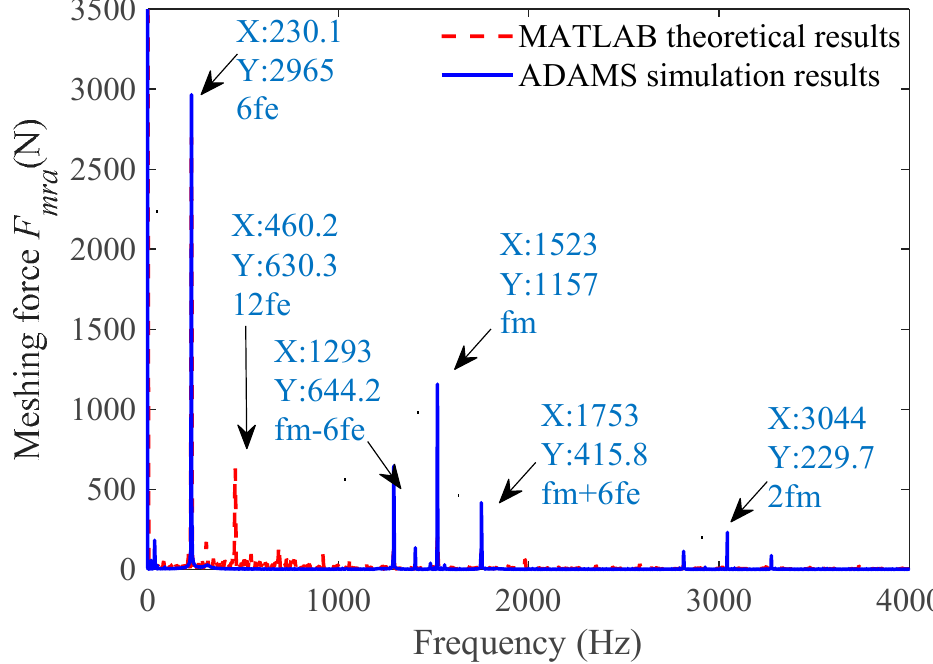
. (cid:3040)(cid:3028)(cid:3029)